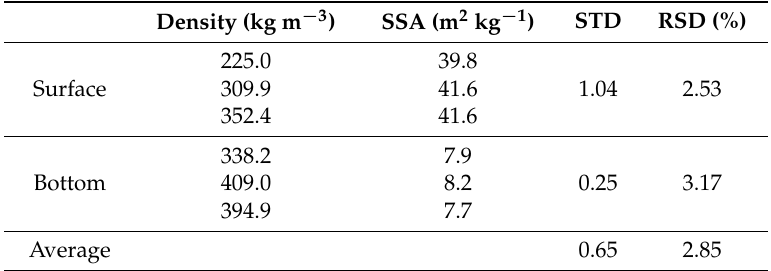
Table 1. The SSA from three samples of precipitation particles at the surface and faceted crystals in the bottom of the snowpack. Standard deviations (STD) and relative standard deviations (RSD) from Equation (3) are calculated for both surface and bottom.